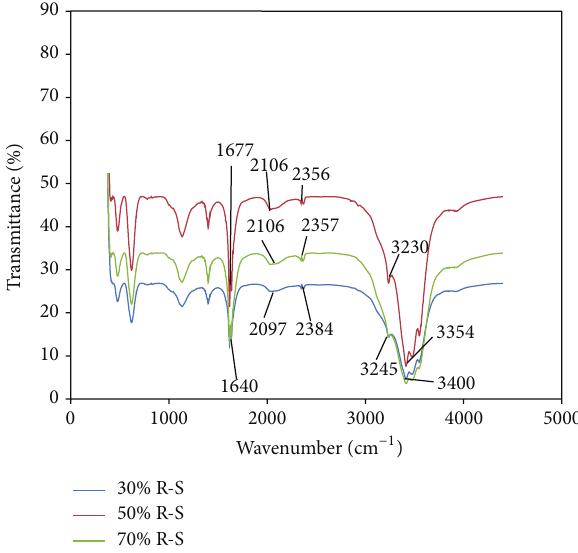
Figure 7: FTIR spectra of blended samples of resin and soot.